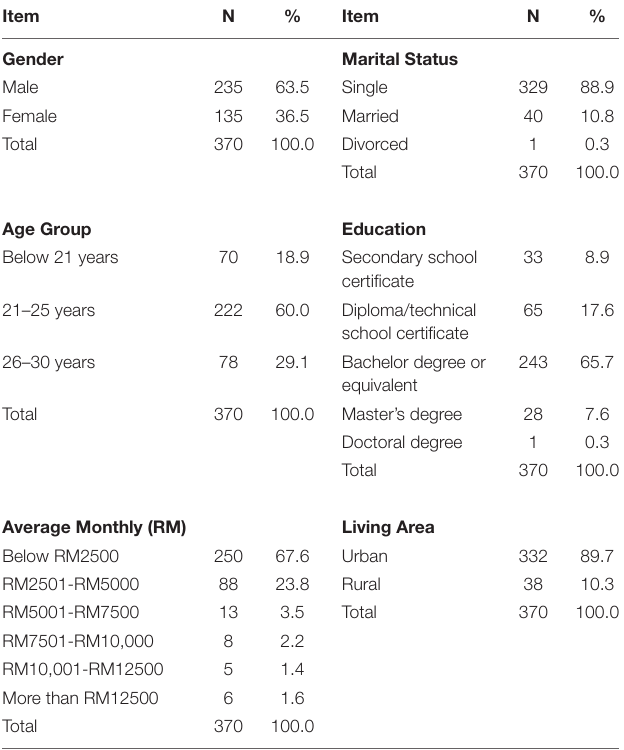
TABLE 1 | Demographic characteristics.